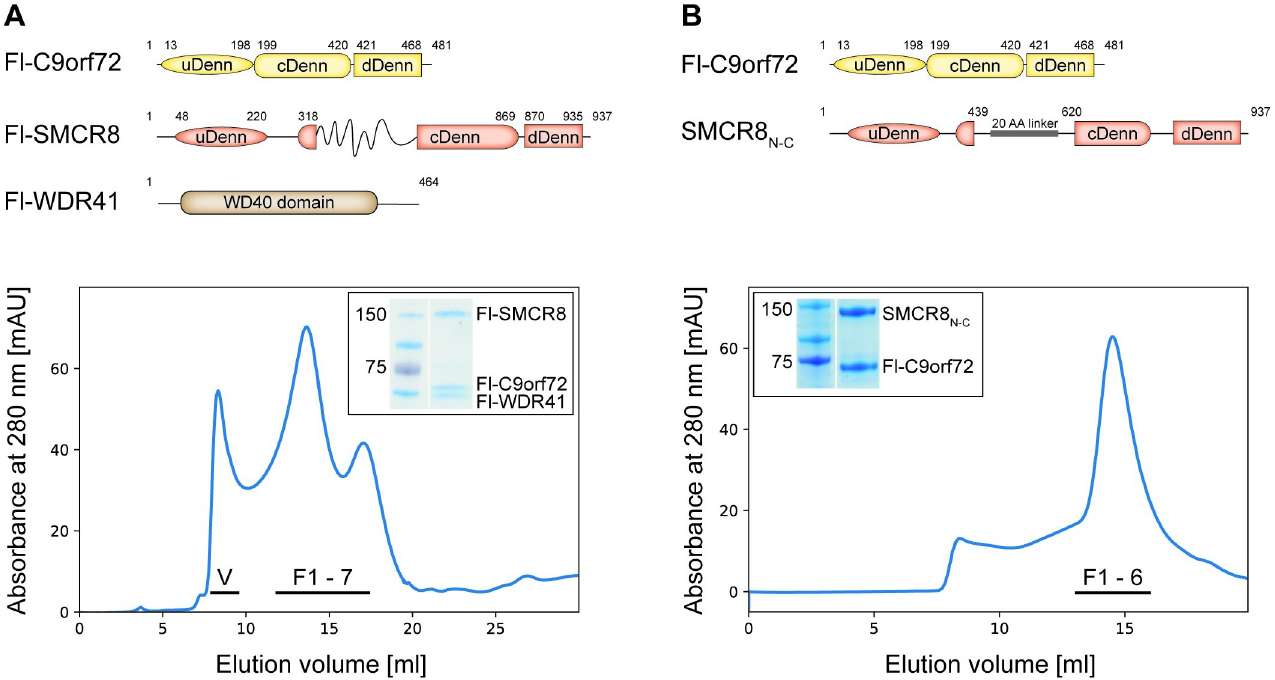
Fig 1. Reconstitution of C9orf72-SMCR8 complex. (A) Domain organization of the full-length C9orf72, SMCR8, and WDR41 proteins (top). Gel filtration profile of the full-length C9orf72 ternary complex is shown (bottom). SDS-PAGE analysis of the peak fraction is shown. (B) Domain organization of the full- length C9orf72 and design of the chimeric SMCR8 construct (top). Gel filtration profile of the C9orf72-SMCR8 N-C binary complex is shown (bottom). SDS-PAGE analysis of the peak fraction is shown. All fractions analyzed by SDS-PAGE are indicated on the profile and shown in S1A and S1C Fig, respectively. The raw images can be found in S1 Raw Images. cDenn, central Denn; dDenn, downstream Denn; Denn, differently expressed in normal and neoplastic cells; Fl, full-length; uDenn, upstream